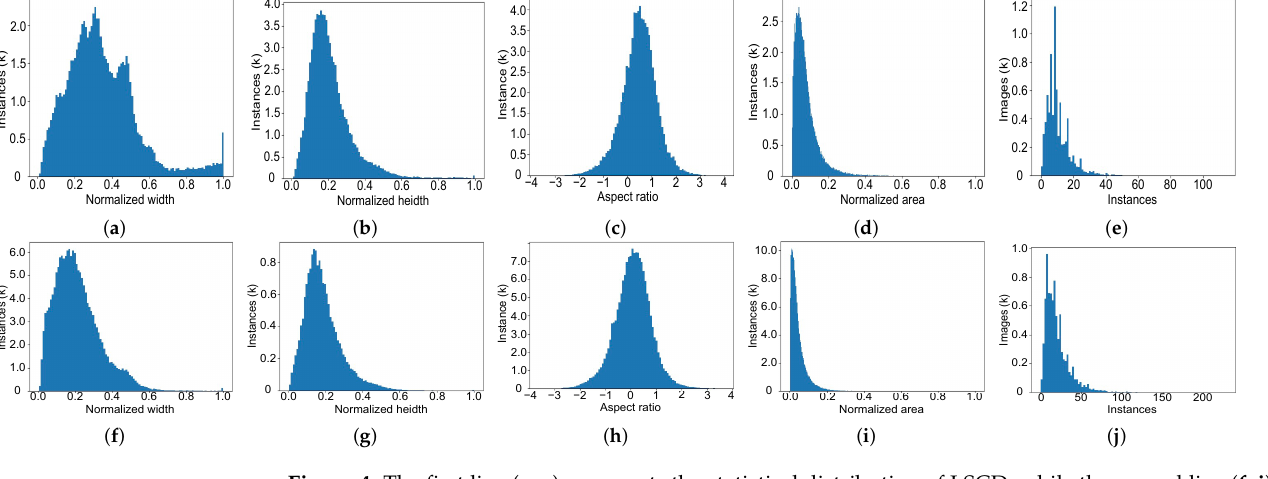
Figure 4. The first line ( a – e ) represents the statistical distribution of LSCD, while the second line ( f – j ) represents the statistical distribution of OSCD. The chart calculates the width, height, aspect ratio, pixel area, and the number of objects in each image from left to right. Note that the width, height, and area of instance are all normalized by the width and height of the corresponding image. The log function is adopted to normalize the aspect